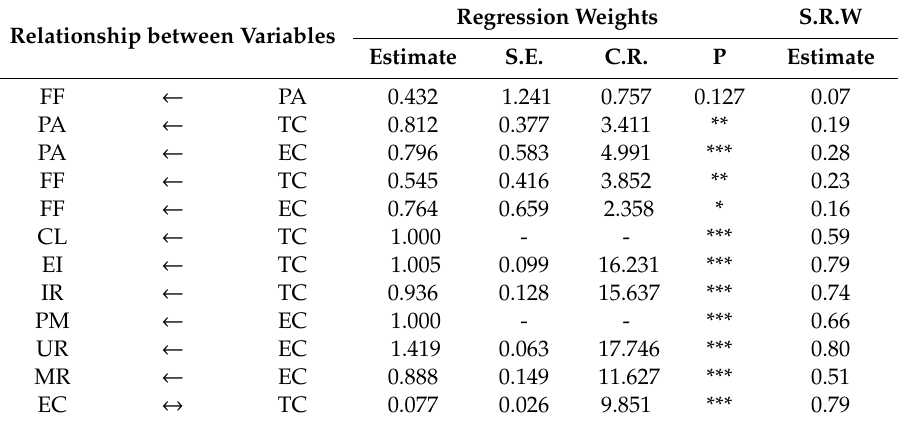
Figure 3. Structural Equation Model in Romanian university students. Note: IR, important role; EI, e ff ort / improvement; CL, cooperative learning; PM, punishment for mistakes; UR, unequal recognition; MR, member rivalry. Table 2. Regression weights for university students from